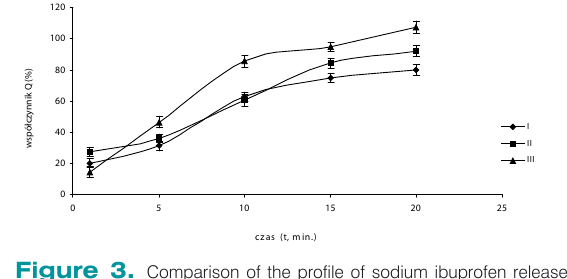
Figure 3. Comparison of the profile of sodium ibuprofen release from batch III tablets in tests with paddle method and teat